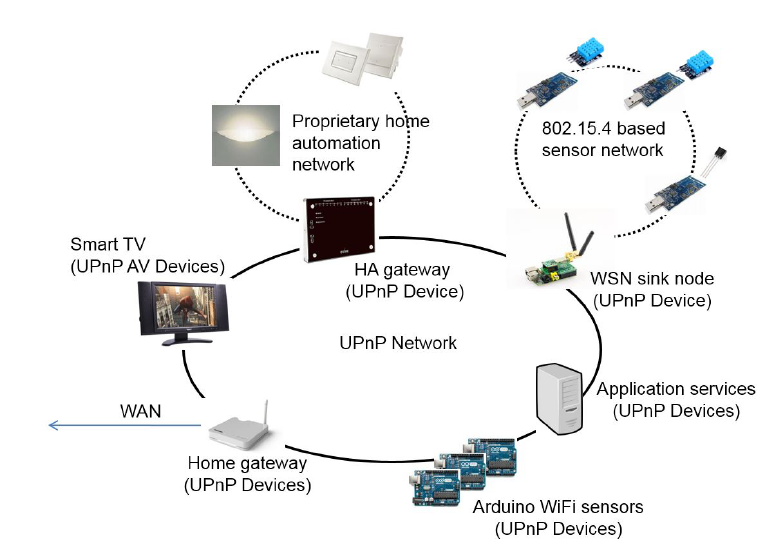
Figure 1. A UPnP-based home network.